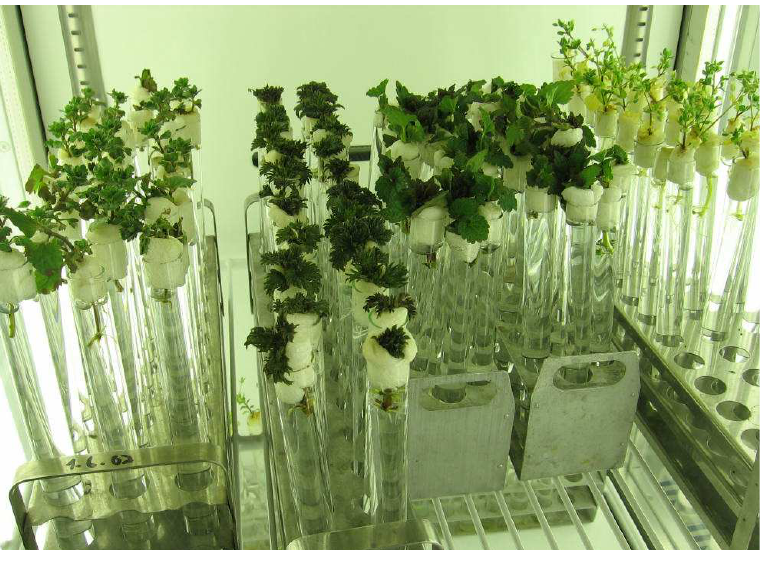
Figure 1. Picture of plants cultivated in an environmental chamber under controlled conditions.